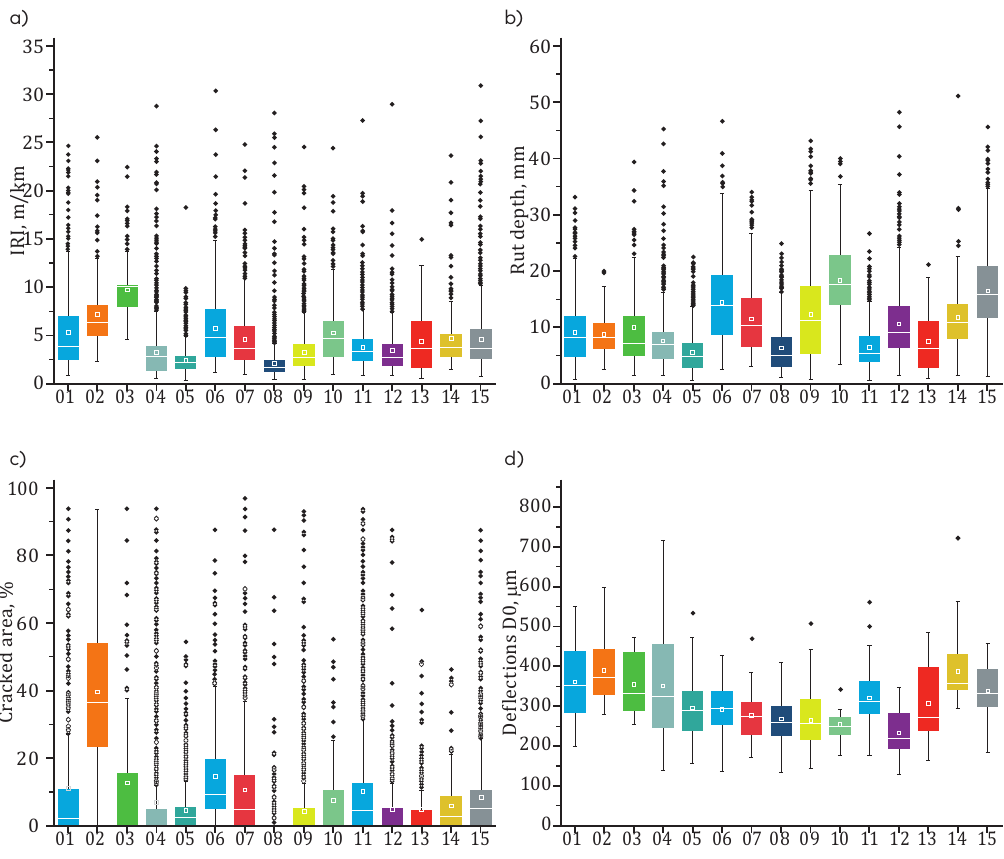
Figure 1. Pavement distress and performance measurement results: a) IRI; b) rut depth; c) defected area; d) FWD